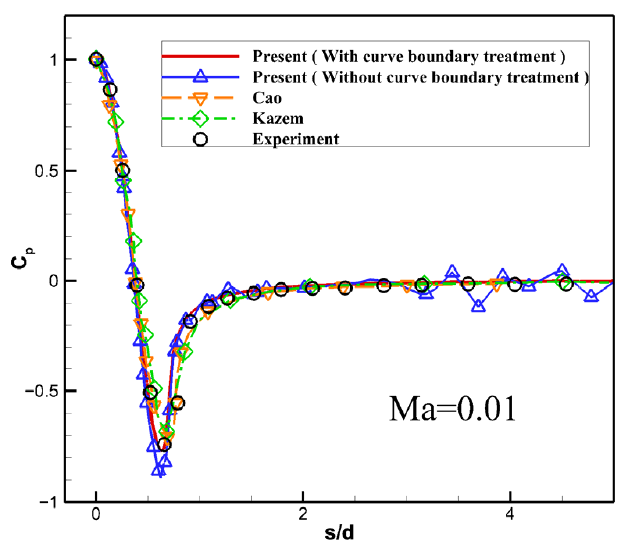
Figure 12. Contours of the Mach number over hemispherical headform. ( a )With curved boundary treatment; ( b ) without curved boundary treatment.